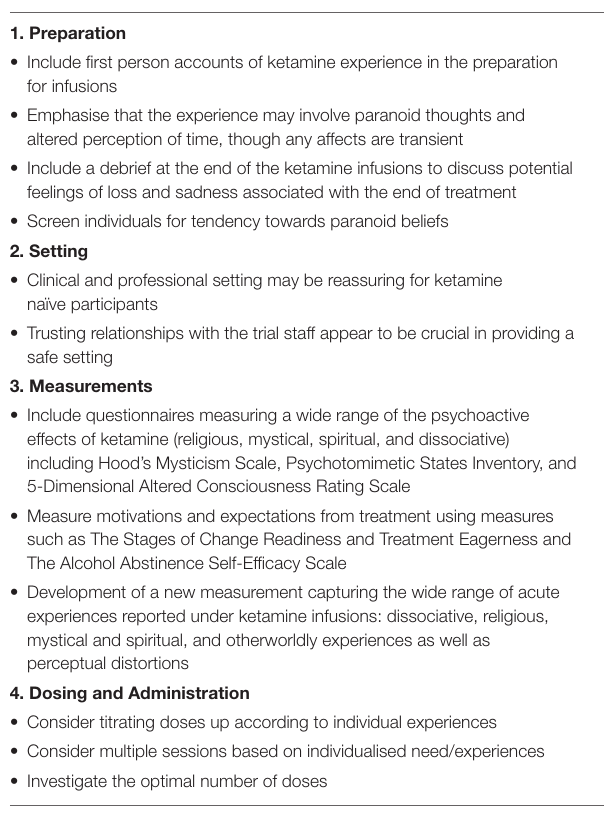
TABLE 3 | A list of recommendations for future trials of ketamine treatment based on current